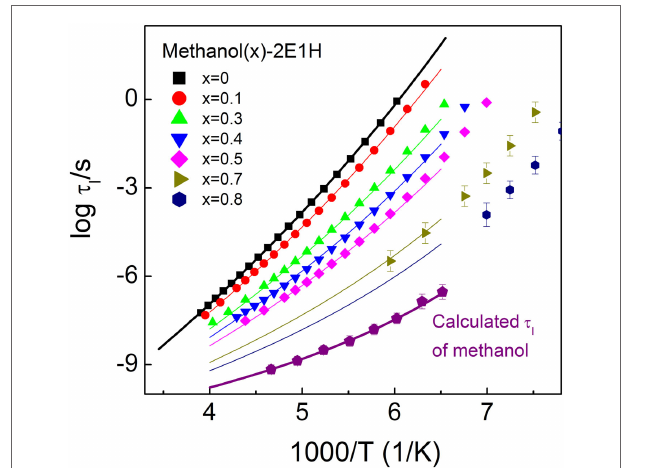
FigUre 8 | Temperature dependence of the relaxation time of the relaxation i for the methanol – 2-ethyl-1-haxanol (2e1h) mixtures . Purple pentagon denotes the average Debye relaxation time of pure methanol, which is calculated when the ideal mixing law is verified. The thin lines are the calculated relaxation time for the mixtures in terms of the ideal mixing law based on the data of pure methanol and 2E1H (thick lines).